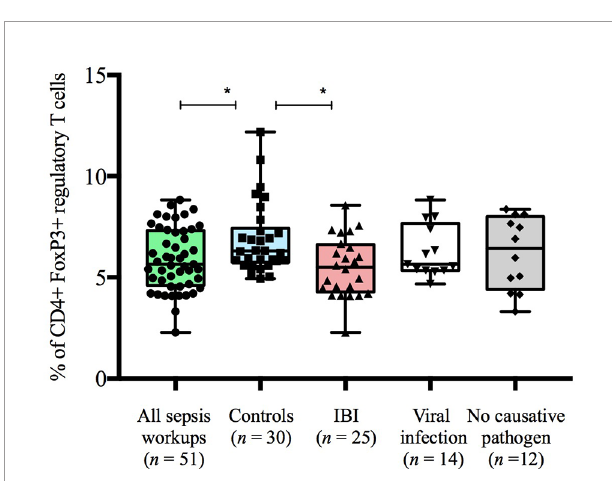
FIGURE 2 | Frequencies of CD4+CD25+ T cells strati fi ed to subgroups of study cohort. Boxes are shown as median and IQR; p-value was derived from Dunn ’ s multiple comparisons test; *p < 0.01.